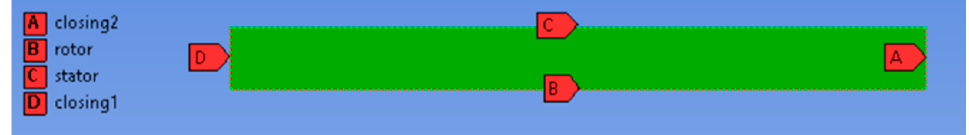
Figure 7. Axisymmetric region and boundary conditions.